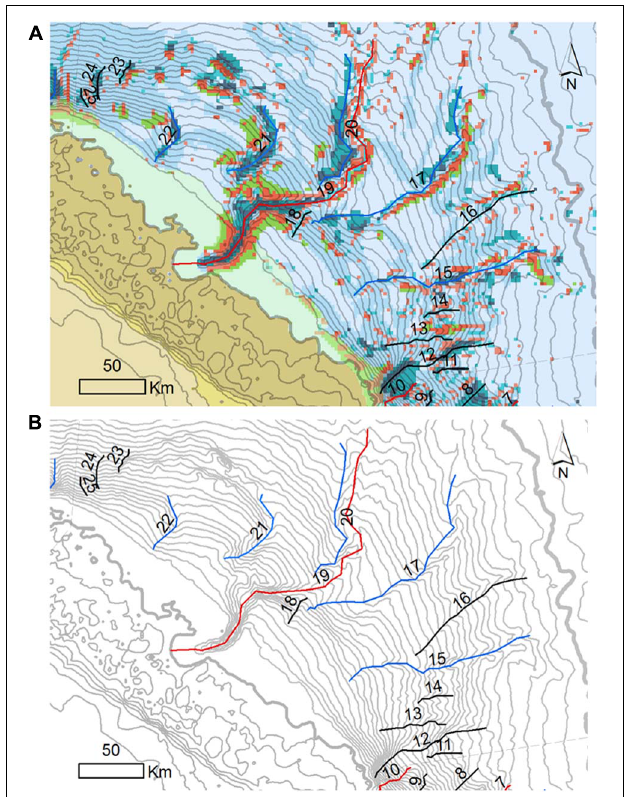
FIGURE 6 | Continental slope depressions in sector S2. Mapping procedures followed the combined methods of delineation by BTM seabed classes thalweg 1 and 2 (A) , and the DTM with isobaths spacing each 100-m water depth interval (B) . Depression types are distinguished by colors: (1) depressions not classified as canyons and confined at the continental shelf (black lines), (2) canyons that are confined to the continental slope (blue lines), and (3) canyons that incise the continental shelf (red lines).